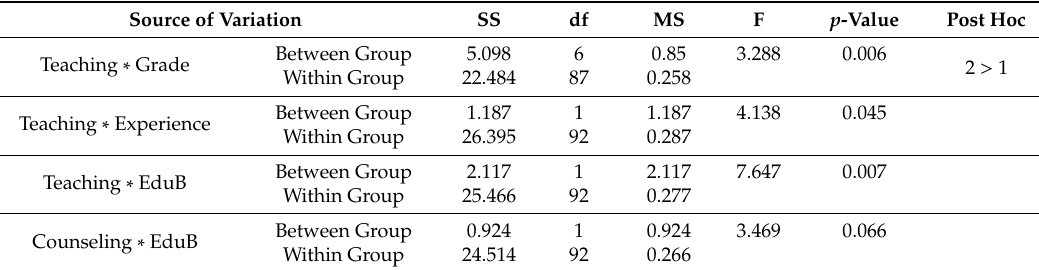
Table 5. Path coefficients. Table 4. ANOVA and post hoc analyses.